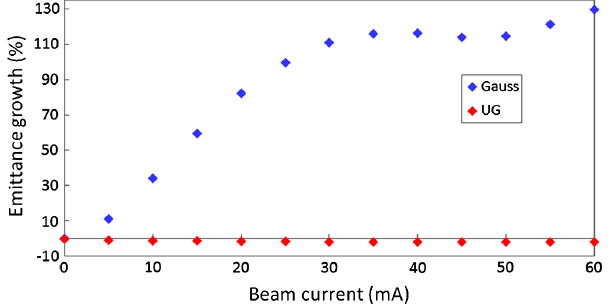
FIG. 1. Emittance growth as a function of the H − beam current simulated with T RACE W IN [8]. The beam energy is 30 keV. Blue: Double-Gaussian initial distribution; Red: UG initial distribution. The drift length is 251 mm, the initial rms beam size is 7.5 mm, and the initial angle is adjusted for each current to provide the final rms size equal to the initial ’ s. Initial beam emittance is 25 μ m (rms, un-normalized) for both distributions. There is no beam